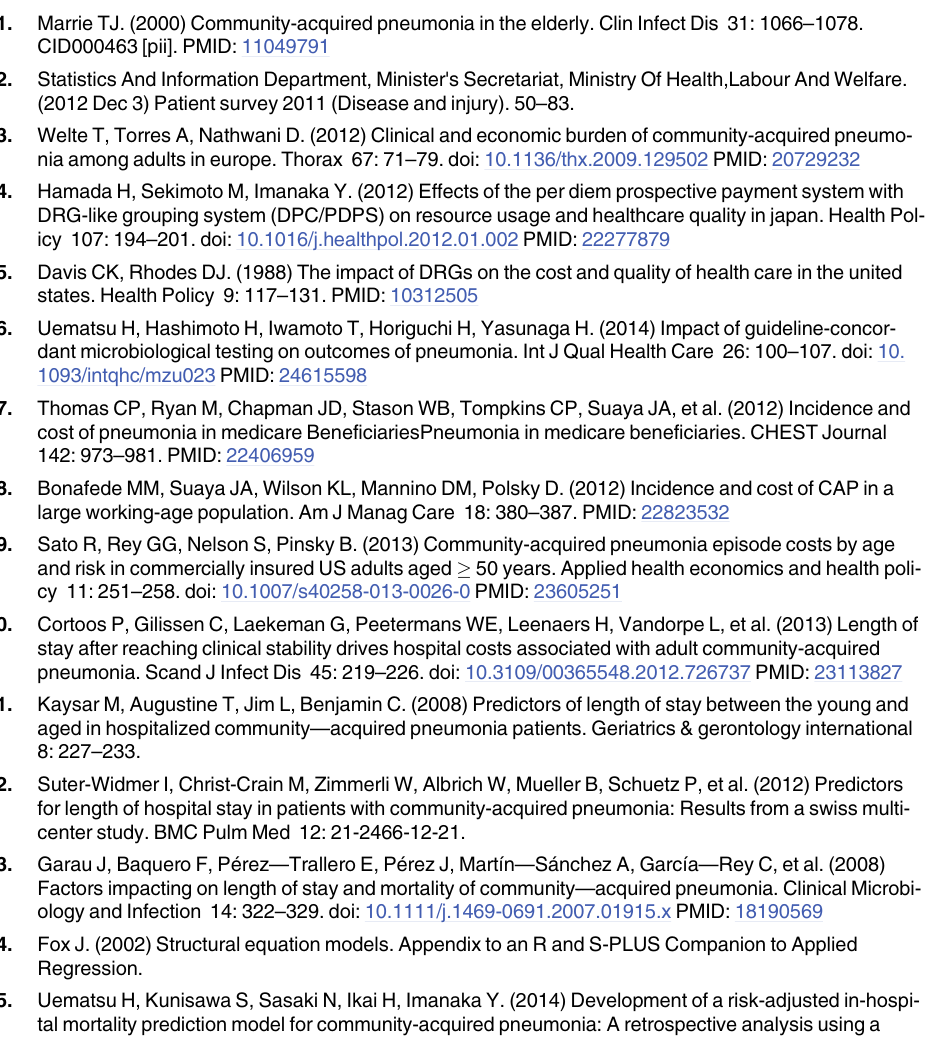
S2 Table. Direct effects of the variables on total hospitalization costs and length of stay using a generalized structural equation model (n = 30,041). Abbreviations: CI, confidence interval. a Hospitalization costs were analyzed using a gamma distribution with a log link. b Length of stay was analyzed using a Poisson distribution with a log link. Log likelihood =